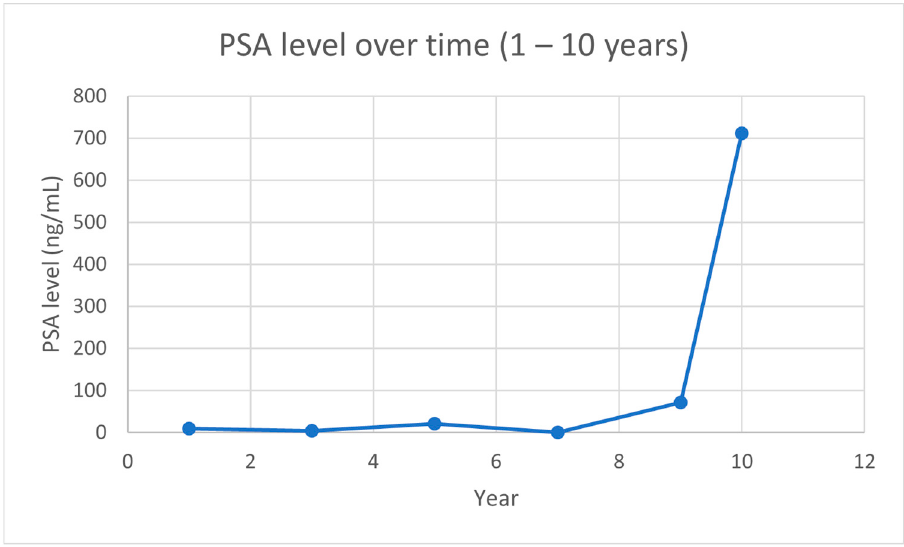
Figure 1. PSA level over time (1 – 10 years).